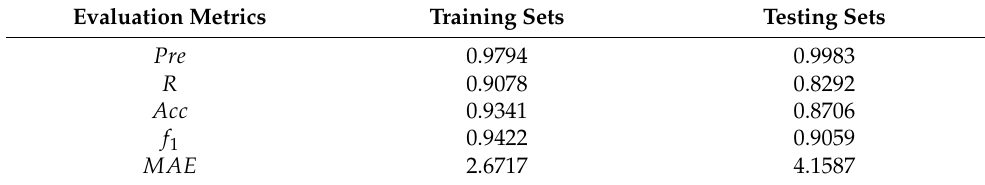
Table 1. Comparison of Pre, R, Acc, f 1 , and MAE